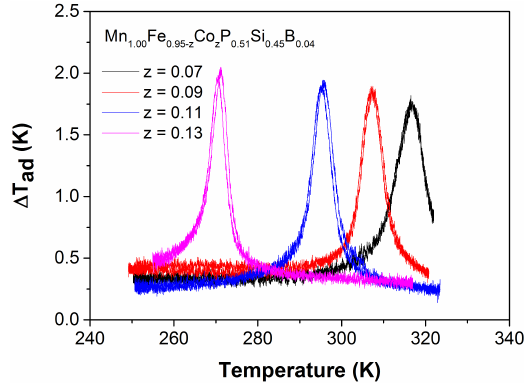
Figure 10. Temperature dependence of the adiabatic temperature change obtained by direct measurements for the Mn 1.00 Fe 0.95 − z Co z P 0.51 Si 0.45 B 0.04 compounds in a magnetic field change of ∆ B = 1.1